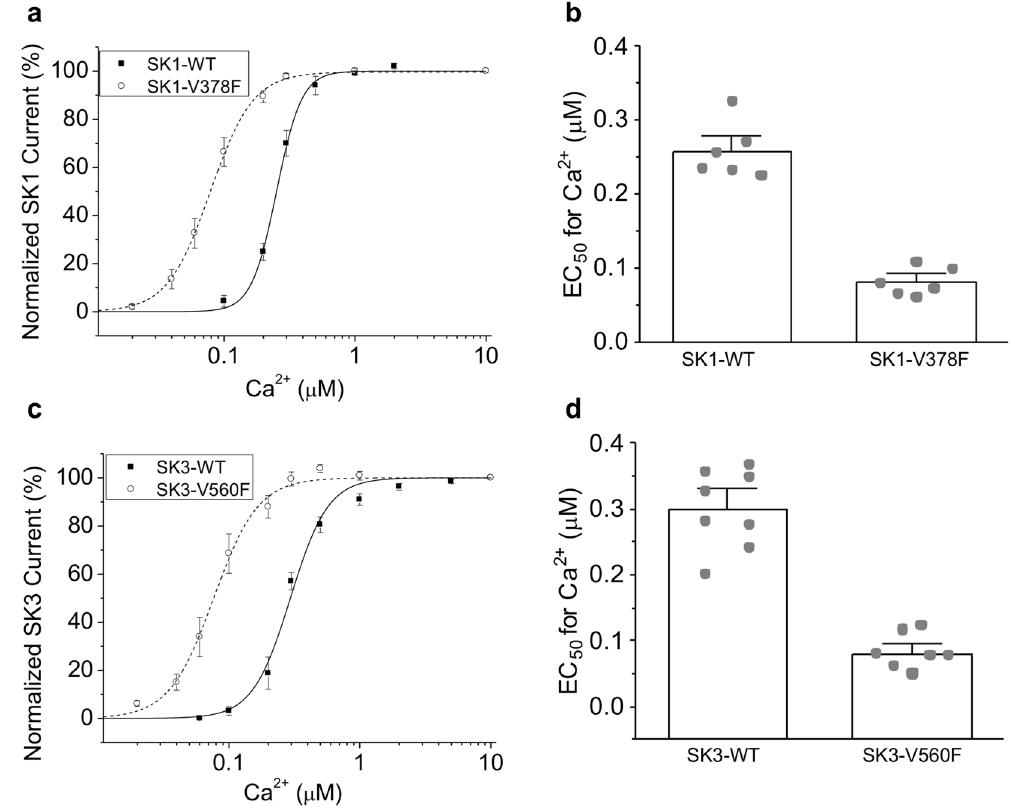
Figure 5. Phenylalanine substitution of the cognate valine in SK1 and SK3 channels increases Ca 2 + sensitivity. ( a ) Dose-dependent activation of the WT and V378F mutant SK1 current by Ca 2 + . ( b ) EC 50 values for the activation of the WT and mutant SK1 channels by Ca 2 + . ( c ) Dose-dependent activation of the WT and V506F mutant SK3 current by Ca 2 + . ( d ) EC 50 values for the activation of the WT and mutant SK3 channels by Ca 2 + . Statistical analysis was performed using two-tailed t -test. All data are presented in mean ±